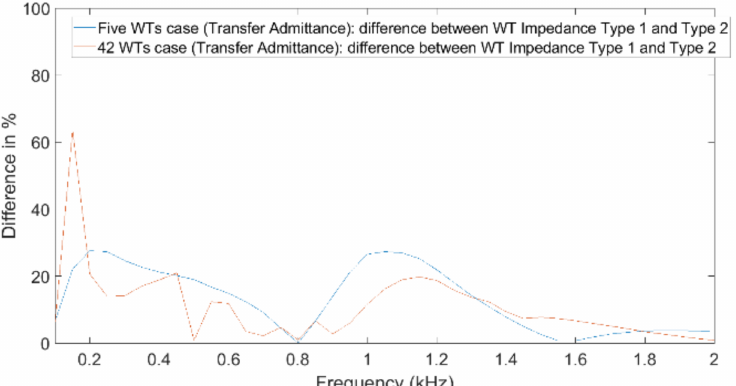
Figure 18. Difference (%) due to WT impedance: transfer admittance (A/V) from all turbines to the public grid in 5- and 42-turbine